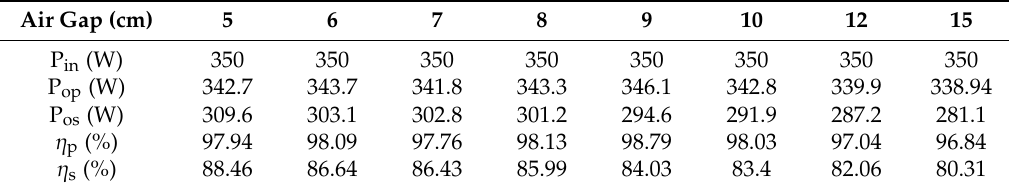
Table 4. Output power versus coupling coe ffi